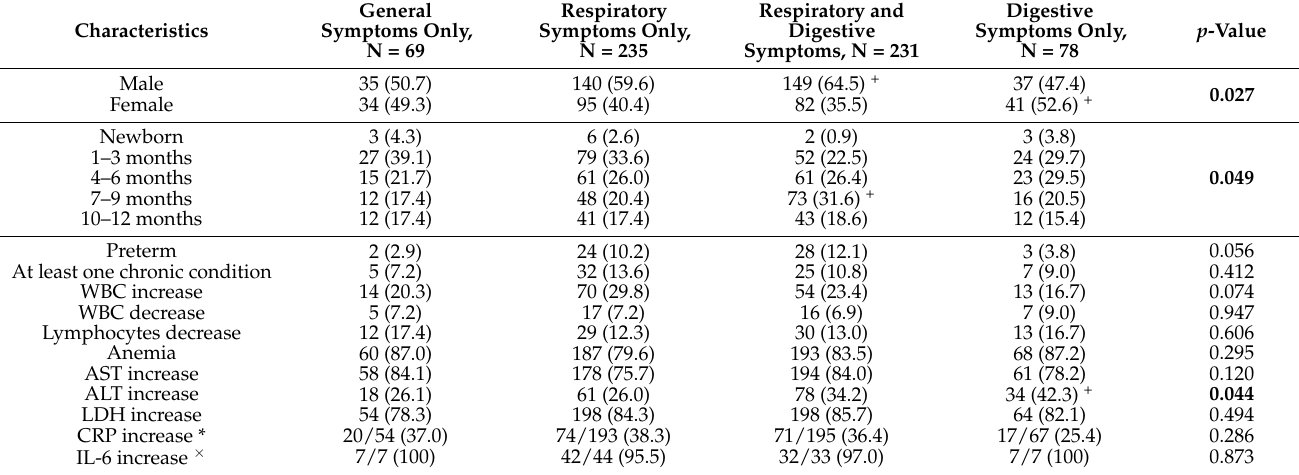
Table 4. Analysis of data according to the type of